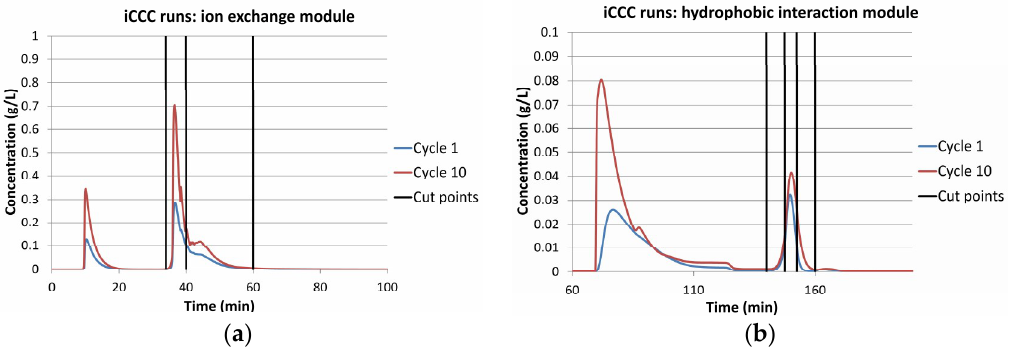
Figure 10. iCCC simulation runs: ( a ) ion-exchange module ( b ) hydrophobic interaction module.